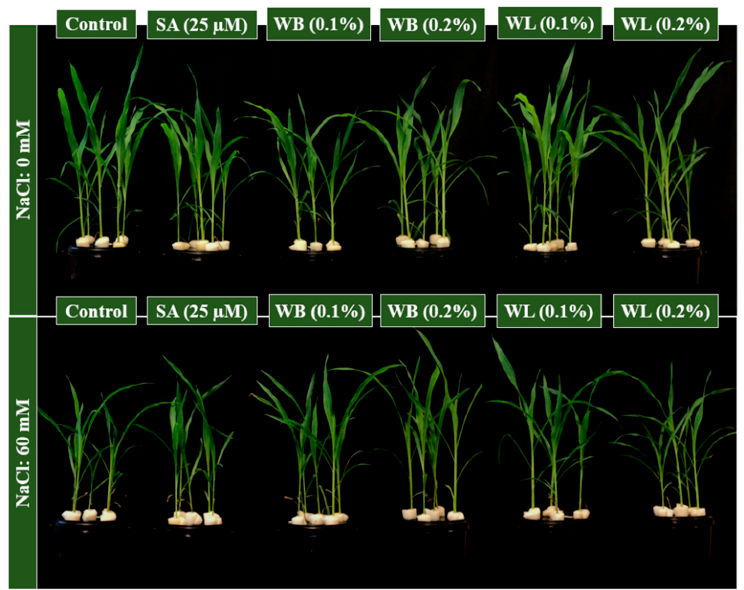
Figure 2. Effect of SA, salicylic acid (25 µM); WB, willow bark extract (0.1% or 0.2% w/v ); WL, willow leaf extract (0.1% or 0.2% w/v ) on plant height of 30 day-old hydroponically grown maize under control (0 mM) or salinity stress (60 mM) conditions.